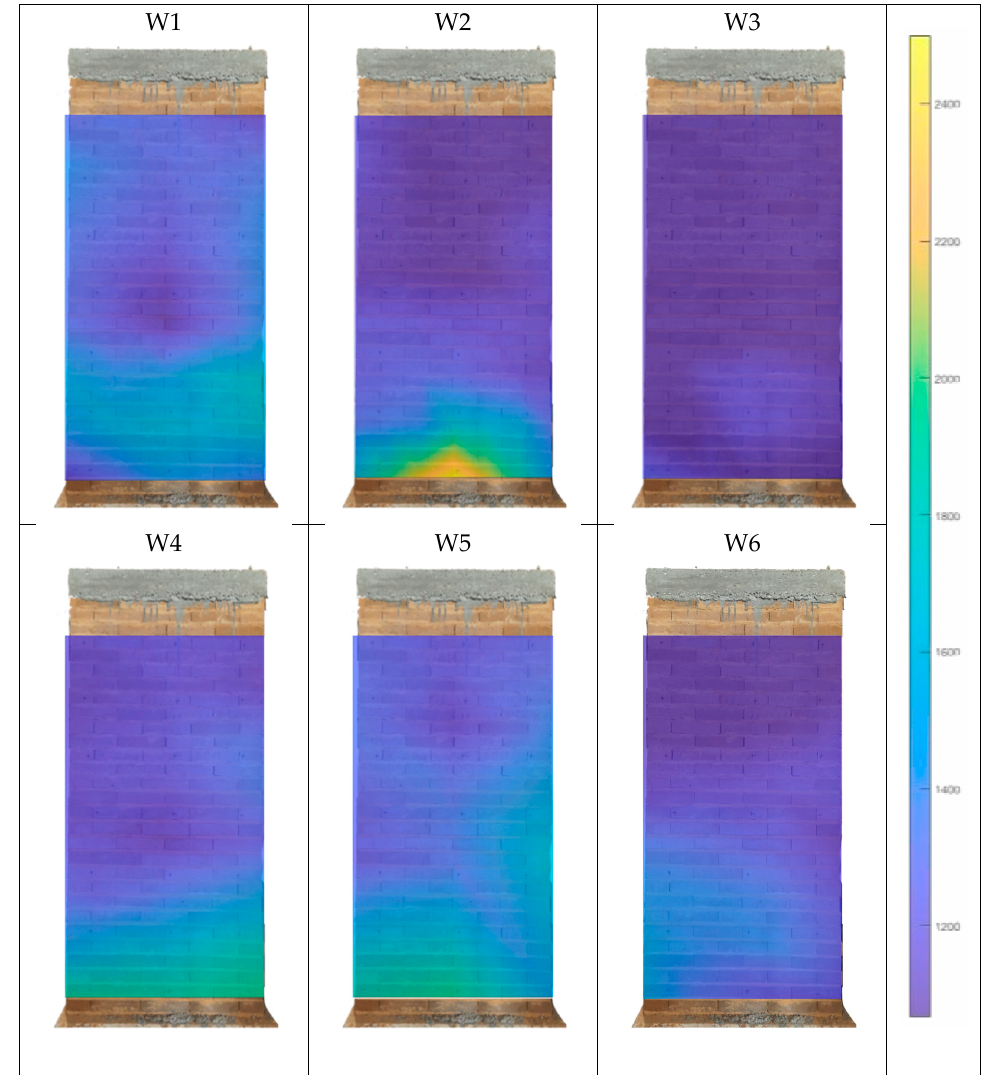
Figure 5. Surface of the indirect tests (vertical slope) velocity data (m/s).